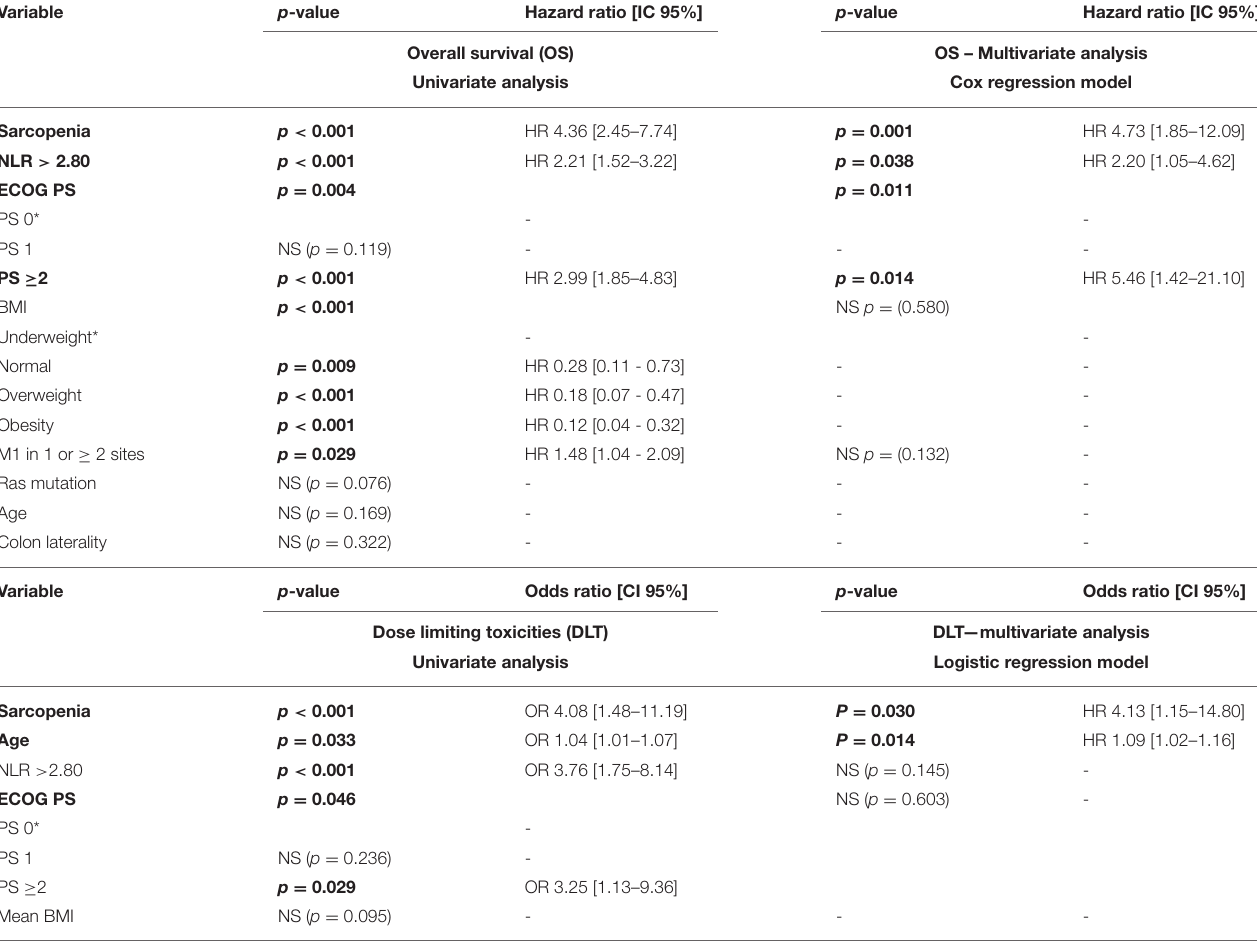
TABLE 2 | Factors influencing OS and DLT.